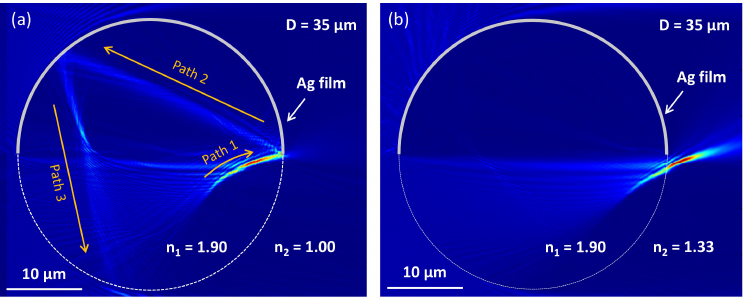
Figure 3. Optical fields of 35 µ m-diameter patchy microcylinders immersed in ( a ) air and ( b )